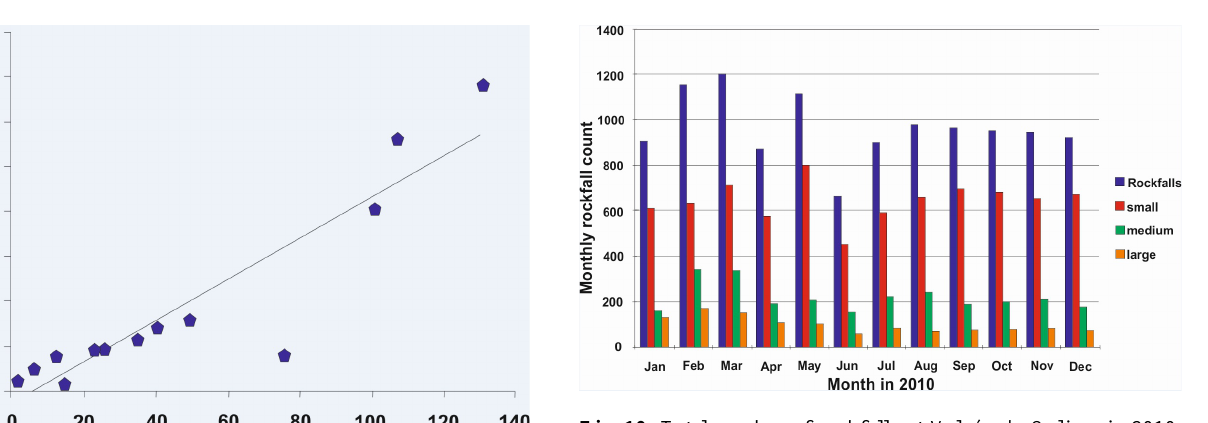
Fig. 10. Total number of rockfalls at Volc´an de Colima in 2010. The blue bar shows the monthly total, red shows the small, green the medium and purple the large rockfalls. The small category is defined by the seismic amplitude being smaller than 3mm on the helicorder output. They are also usually shorter than 60s in dura- tion. The medium category has amplitudes smaller than 7mm; their duration usually never exceeds 180s. All rockfalls with an ampli- tude greater than 7mm count as large rockfalls. All the data shown in this figure is gained from the daily helicorder records for the year 2010 of the EZV4/SOMA station in the RESCO Volc´an de Colima seismic